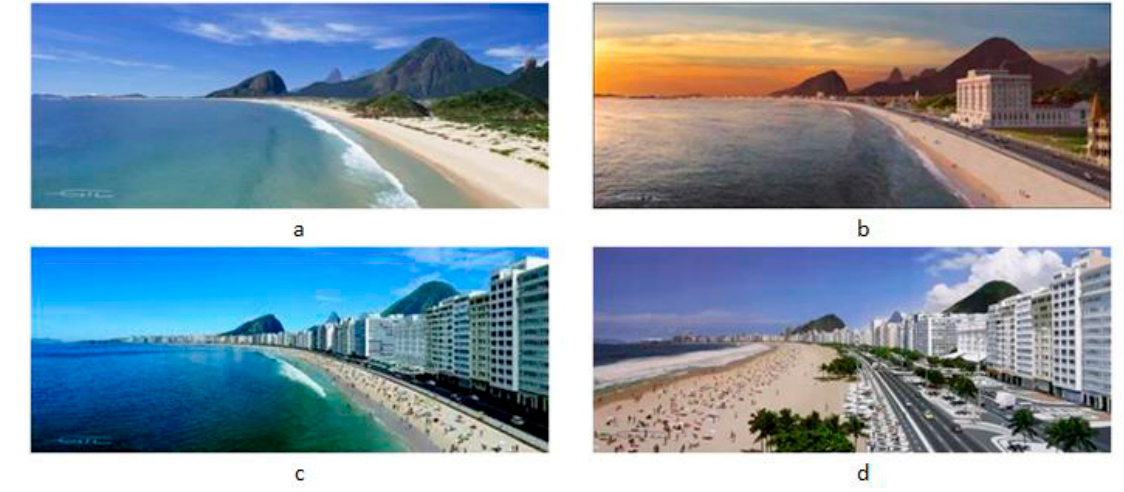
Figure 1. Copacabana at four time points: ( a ) 1893 ( b ) 1927 ( c ) 1956 ( d ) 2008. Source: [16] .